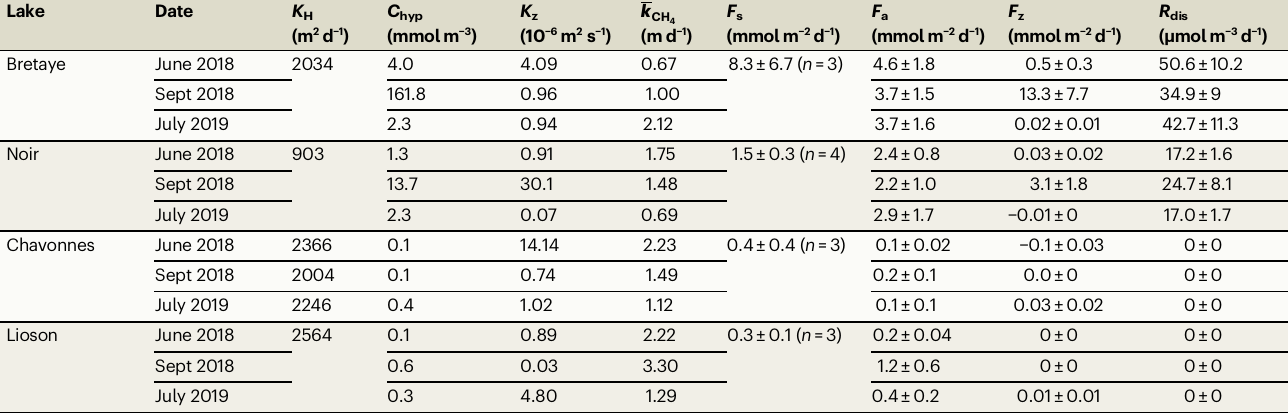
Table 2 | Inputs for the lateral transport model and full-scale mass balance in the surface mixed layer (SML) (mean ± SD)